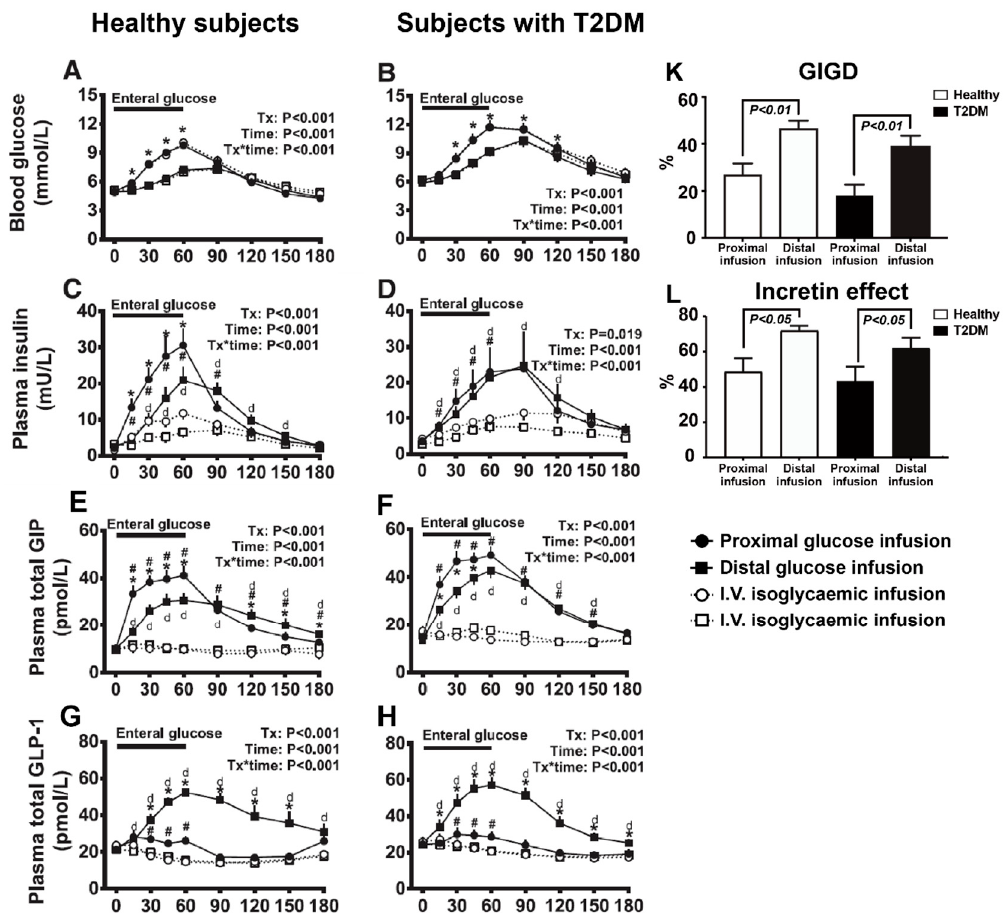
Figure 3. Comparative effects of proximal and distal small intestinal glucose exposure on glycaemia, incretin hormone secretion, and the incretin effect in both healthy individuals and patients with type 2 diabetes (T2DM) ( n = 10 each). ( A , B ) Blood glucose levels, ( C , D ) plasma insulin, ( E , F ) plasma total glucose-dependent insulinotropic polypeptide (GIP), ( G , H ) plasma total glucagon-like peptide 1 (GLP-1), ( K ) Gastrointestinal-mediated glucose disposal (GIGD), and ( L ) Incretin effect. * p < 0.05 for proximal vs. distal enteral glucose infusion; # p < 0.05 for proximal enteral vs. corresponding i.v. glycaemic glucose infusion; d p < 0.05 for distal enteral vs. corresponding i.v. glycaemic glucose infusion. Data are mean ± SEM. (Figures are adapted from reference [137], with permission from Diabetes Care, 2019).